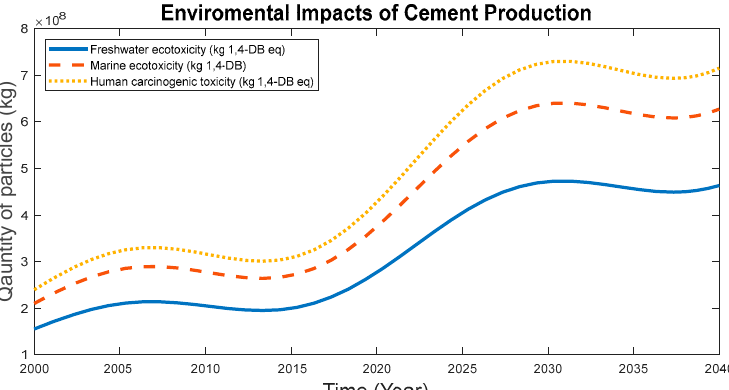
Figure 5. Plot showing a possible long-term environmental impact of cement production in South Africa. Freshwater ecotoxicity measured in kg 1,4-DB eq, marine ecotoxicity measured in kg 1,4-DB eq and human carcinogenic toxicity measured in kg 1,4-DB eq.